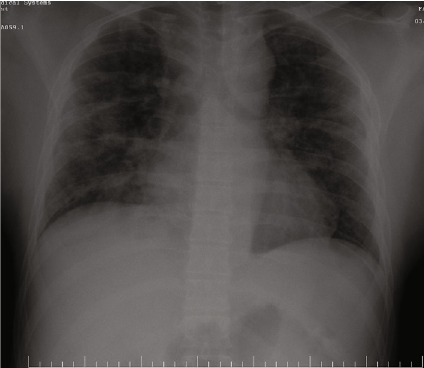
Figure 2: Patient ’ s CT